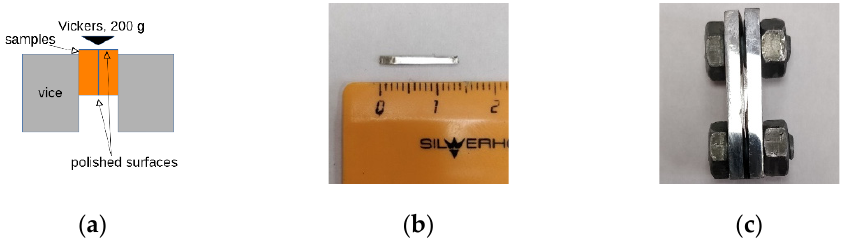
Figure 1. Joint indentation scheme: ( a ) samples are clamped in vice polished surfaces to each other; ( b ) a sample cut from HPT n = 1 BMG; ( c ) samples are clamped in a vice.